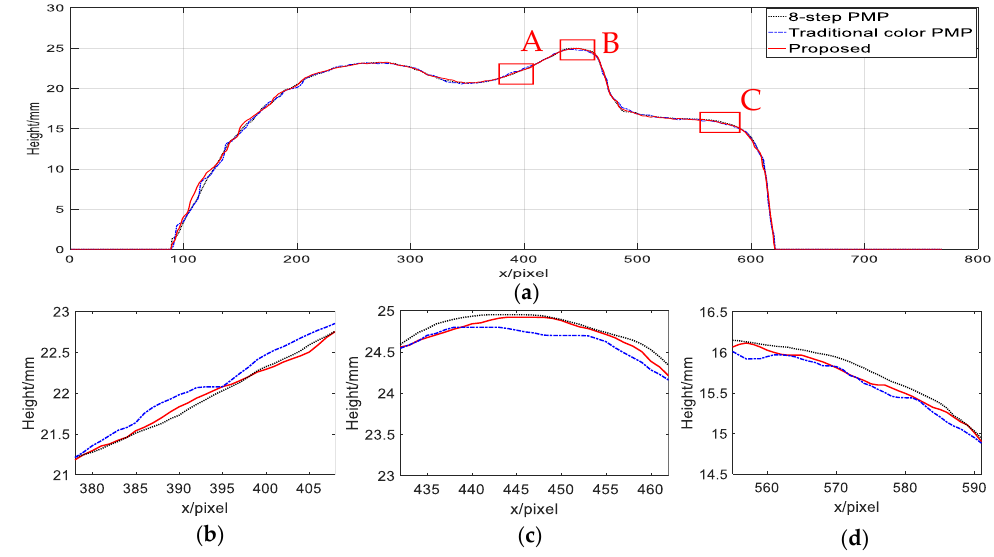
Figure 7. ( a ) The 547th column data of the reconstructed result; and ( b – d ) zooms in of Regions A–C in ( a